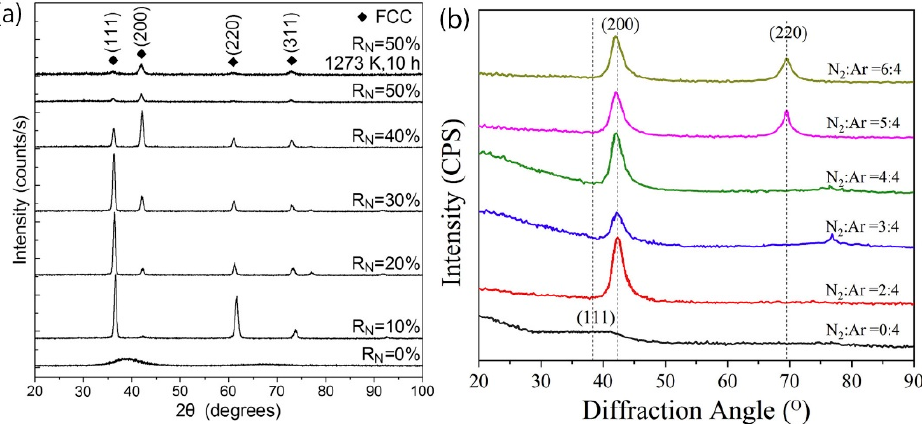
Figure 5. X-ray diffractograms showing the evolution of the structure as a function of the nitrogen flow rate. ( a ) reproduced and modified with permission ref. [20] copyright 2011 Thin Solid Films. ( b ) reproduced and modified with permission of ref. [76]. Copyright 2020 Vacuum